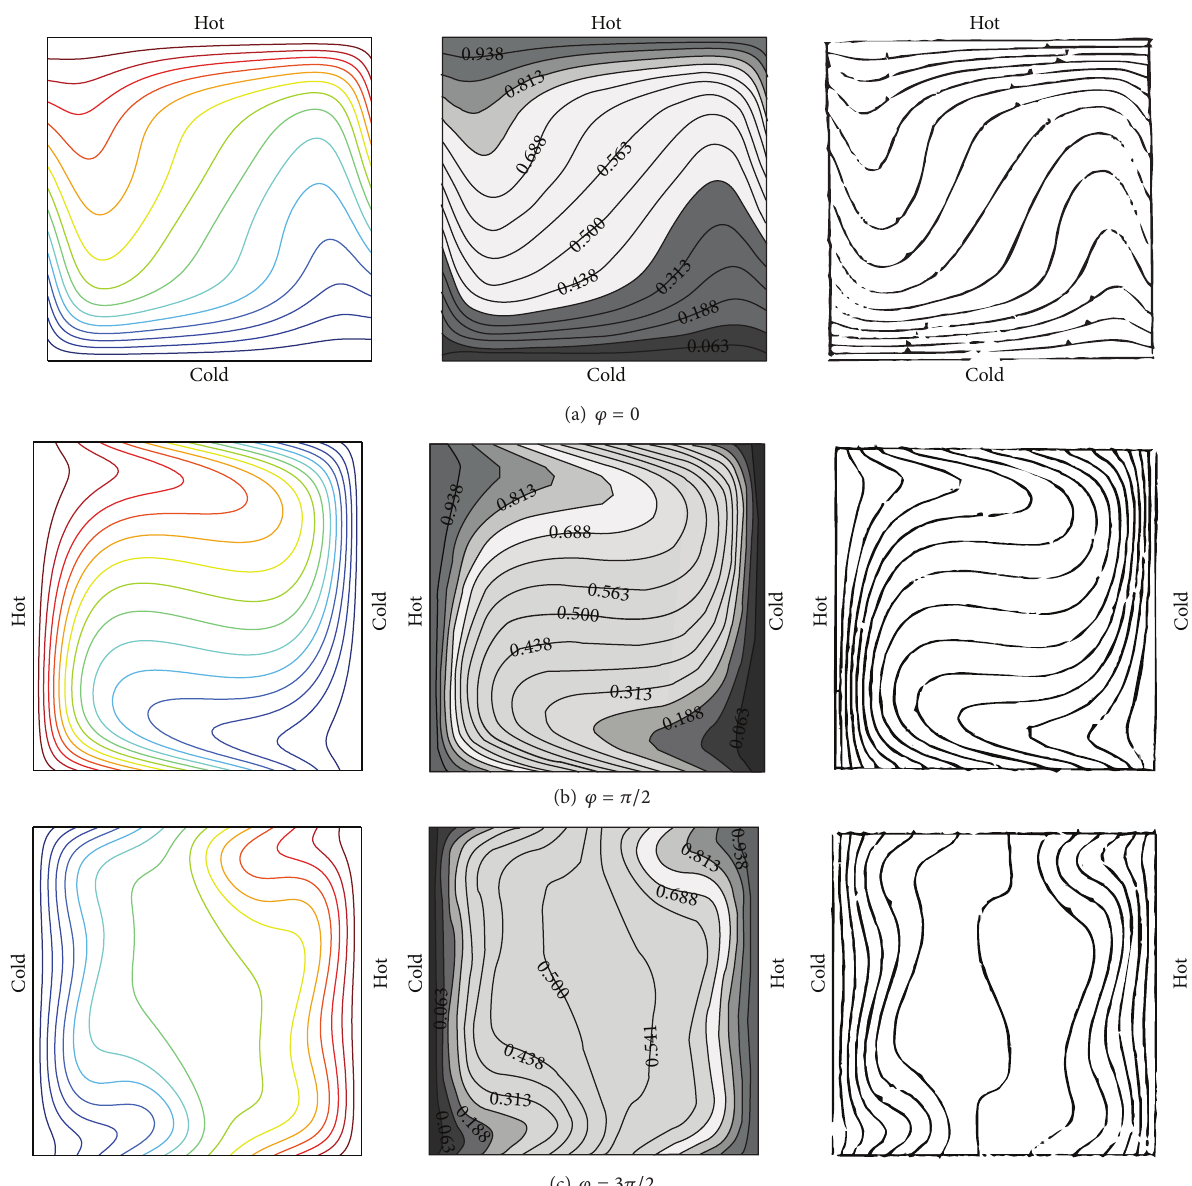
Figure 4: Comparison of computed isotherms of present work (left) with Tso et al. [11] (middle) and Hamady et al. [4] (right) results in Pr = 0.7 , Ra = 1.2 × 10 5 , Ta = 8.9 × 10 4 , and Ω = 8.5